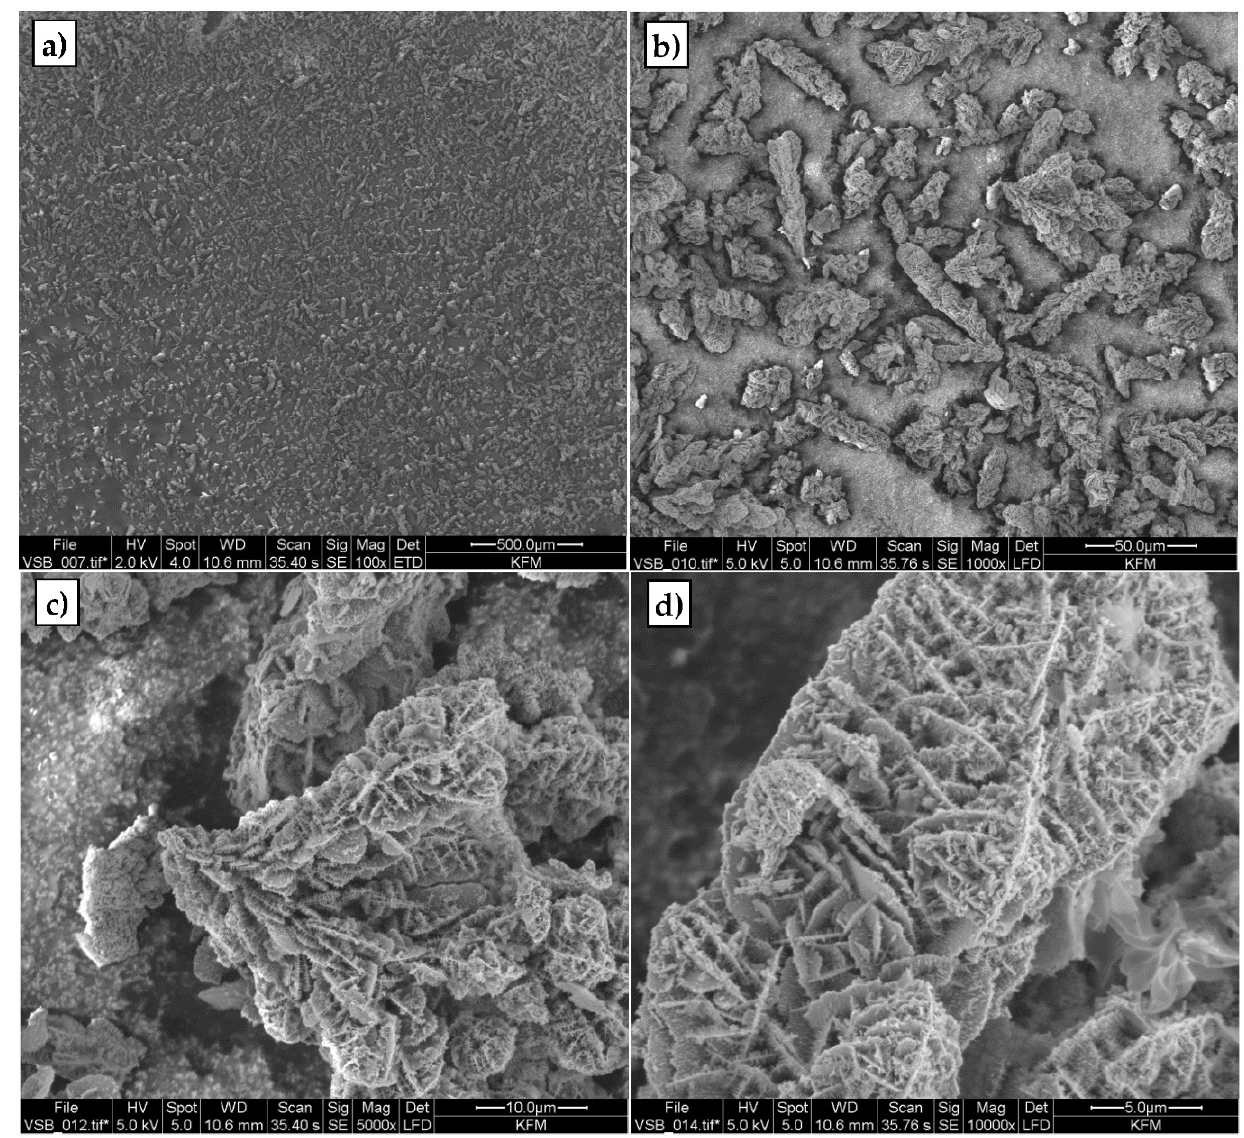
Figure 11. Microstructure of Zn powder (SEM analysis) after electrolysis process at various enlargement—sample D22. ( a ) Zinc particles at low magnification. ( b ) Dendritic structure of the sample at higher magnification. ( c ) Small whiskers are visible on the surface of the zinc particles. The thickness of the lamellae is about 10 nm. ( d ) The zinc particles are very thin. The surface was indented, and the arrangement resembles a fine dendritic